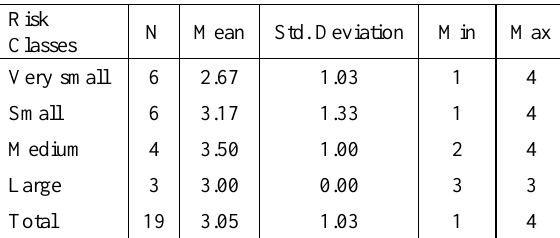
Table 4. The average fire risk values for the fire area